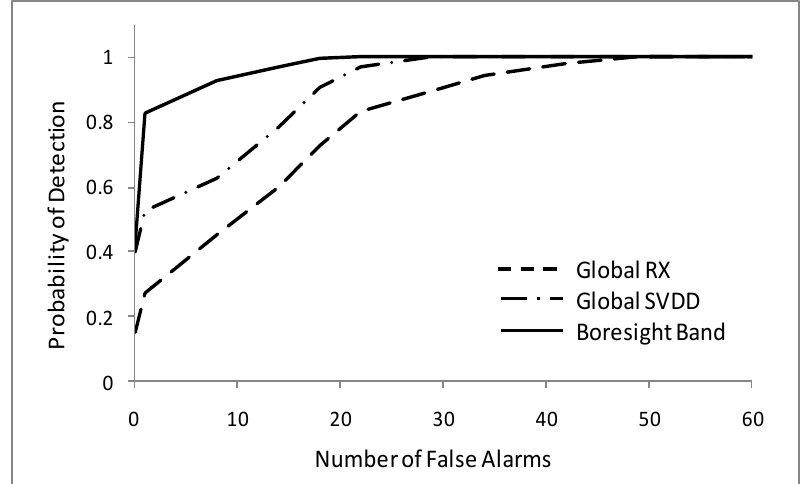
Figure 12. ROC performance for the global RX, SVDD and boresight band detectors.